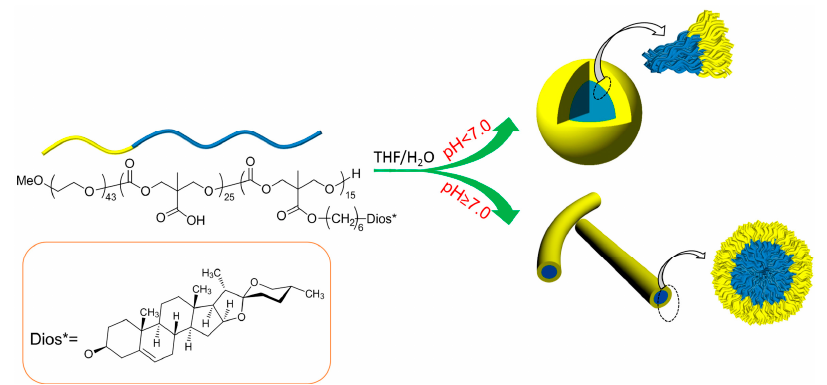
Figure 5. Self-assembly of mPEG 43 -PMCC 25 -P(MCC-DHO) 15 with nanospheres and nanofibers micelles.